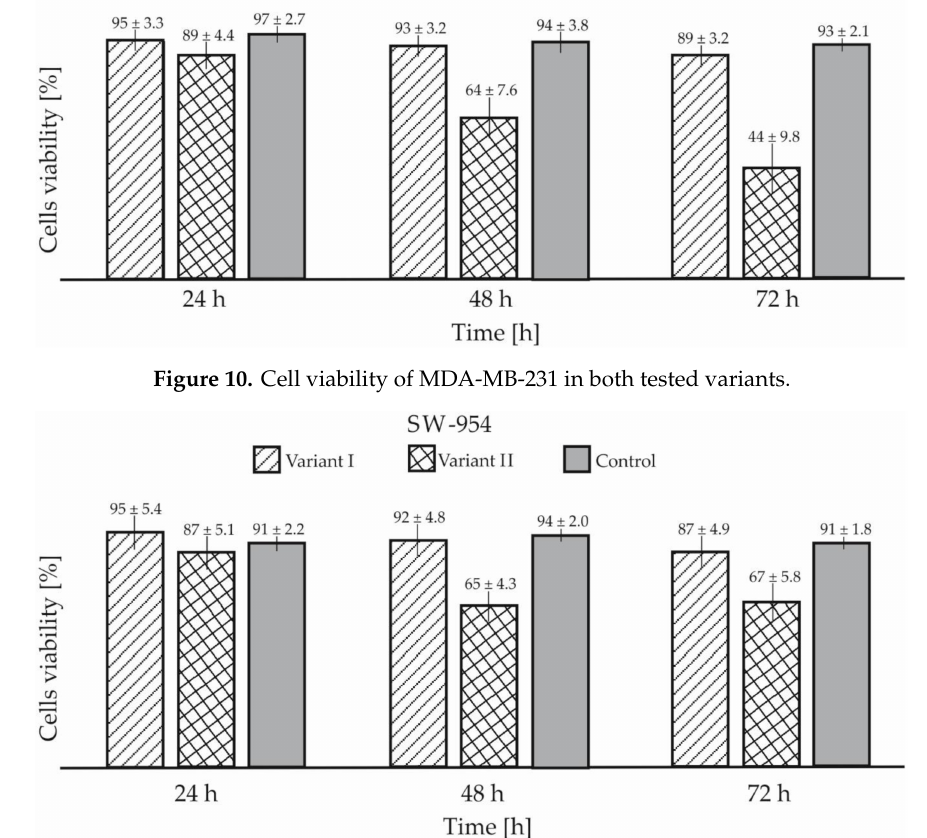
Figure 11. Cell viability of SW-954 in both tested